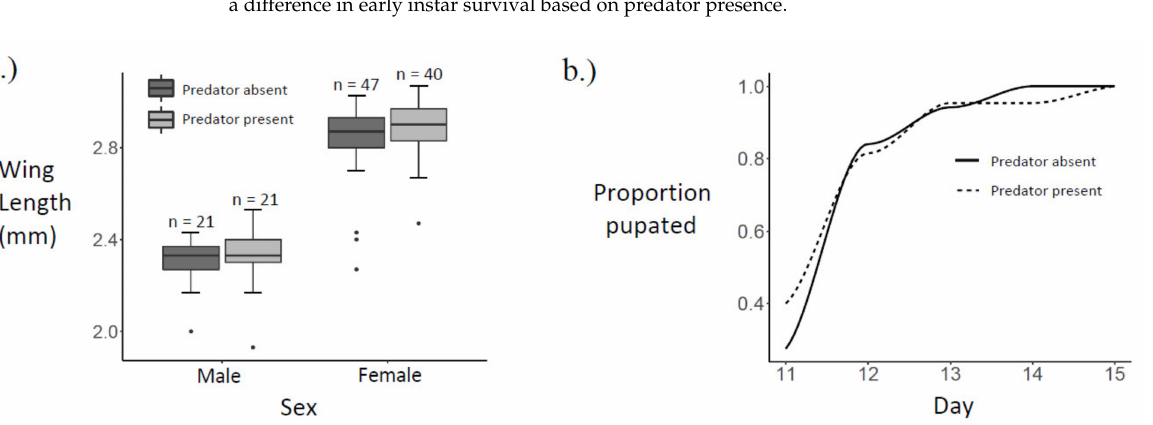
Figure 3. Size and development: ( a ) Boxplot of wing lengths by sex and predator presence; ( b ) cumulative proportion pupated by predator